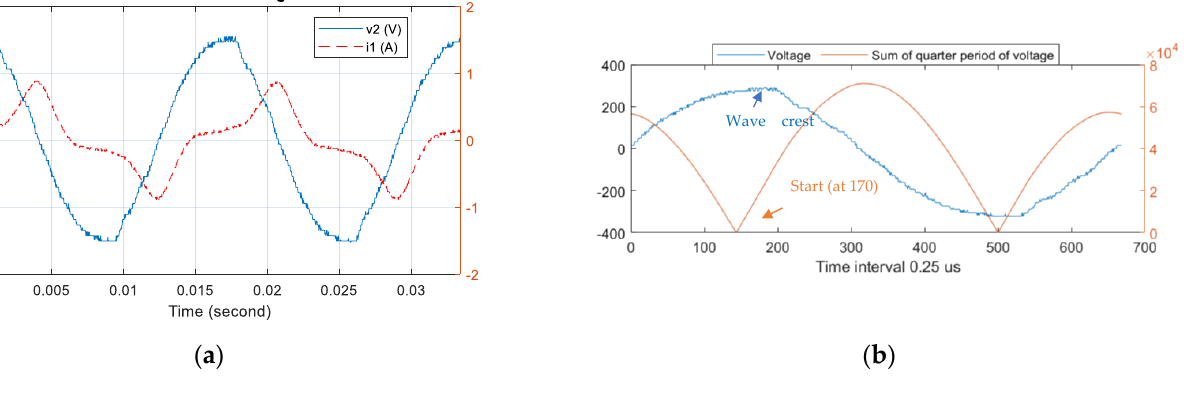
Figure 12. Integration waveform after correction of initial position and removal of DC components. ( a ) Distorted voltage integration waveform ( b ) Using the sum of the quarter to find the initial integration position of the harmonics-based sine wave.